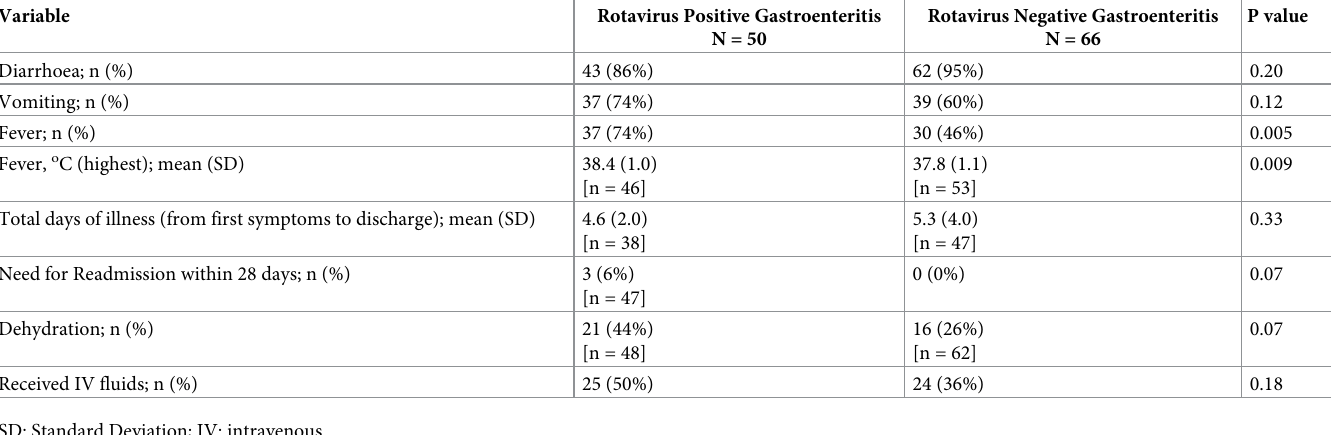
Table 2. Presentation and management of children with rotavirus-positive and rotavirus-negative gastroenteritis. Variable